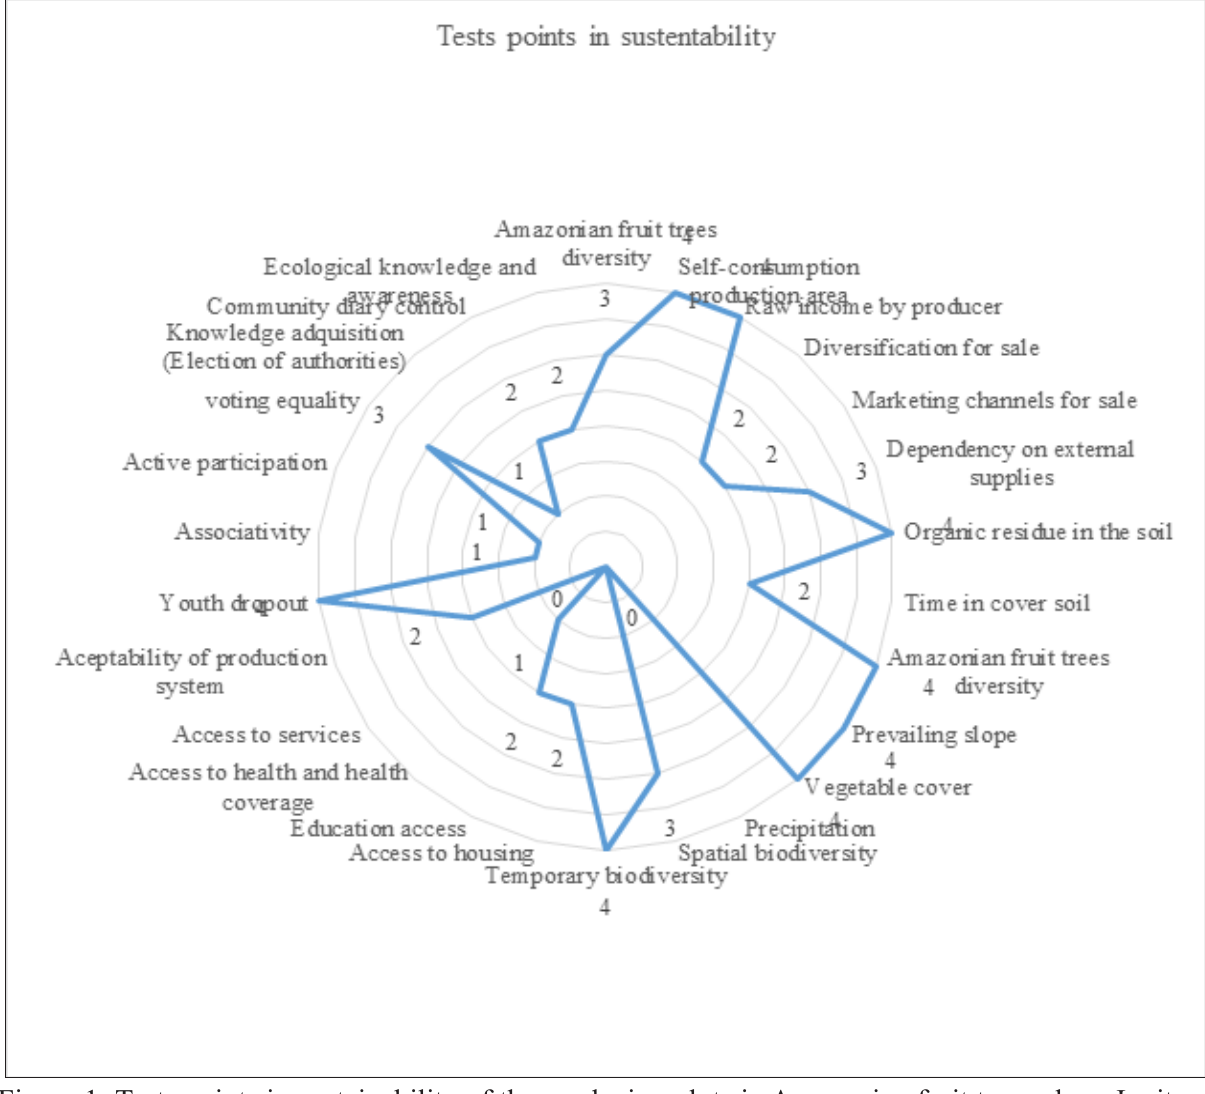
Figure 1: Tests points in sustainability of the producing plots in Amazonian fruit trees along Iquitos – Nauta, road in